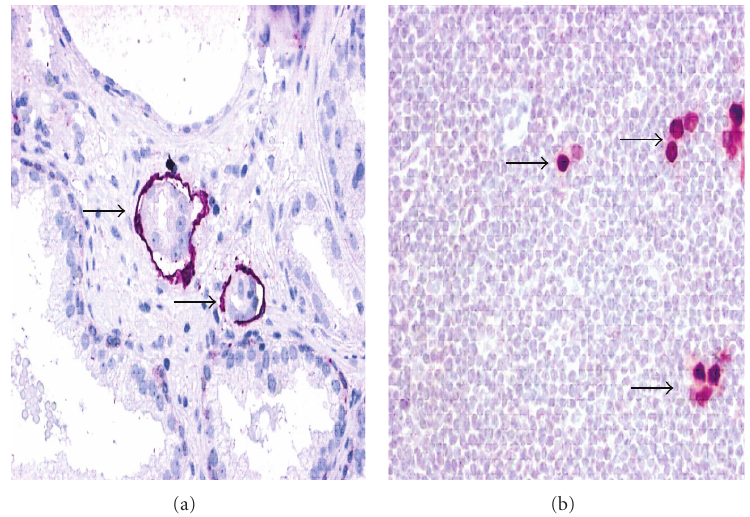
Figure 1: Lymphovascular invasion is detected by the endothelial marker D2-40 in a prostatectomy specimen (a). Androgen receptor (AR) immunohistochemistry detects disseminated prostate cancer cells in lymph nodes classified as negative for cancer upon routine histological examination. Original magnifications: a ( × 400), b ( ×